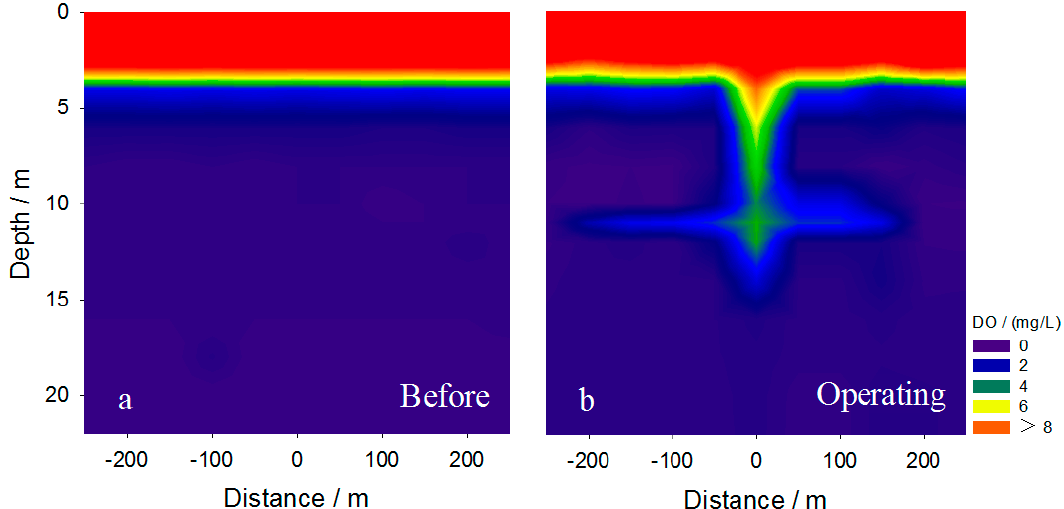
Figure 4. Spatial variation of dissolved oxygen (DO) in the water column ( a ) before and ( b ) during operation of the apparatus.